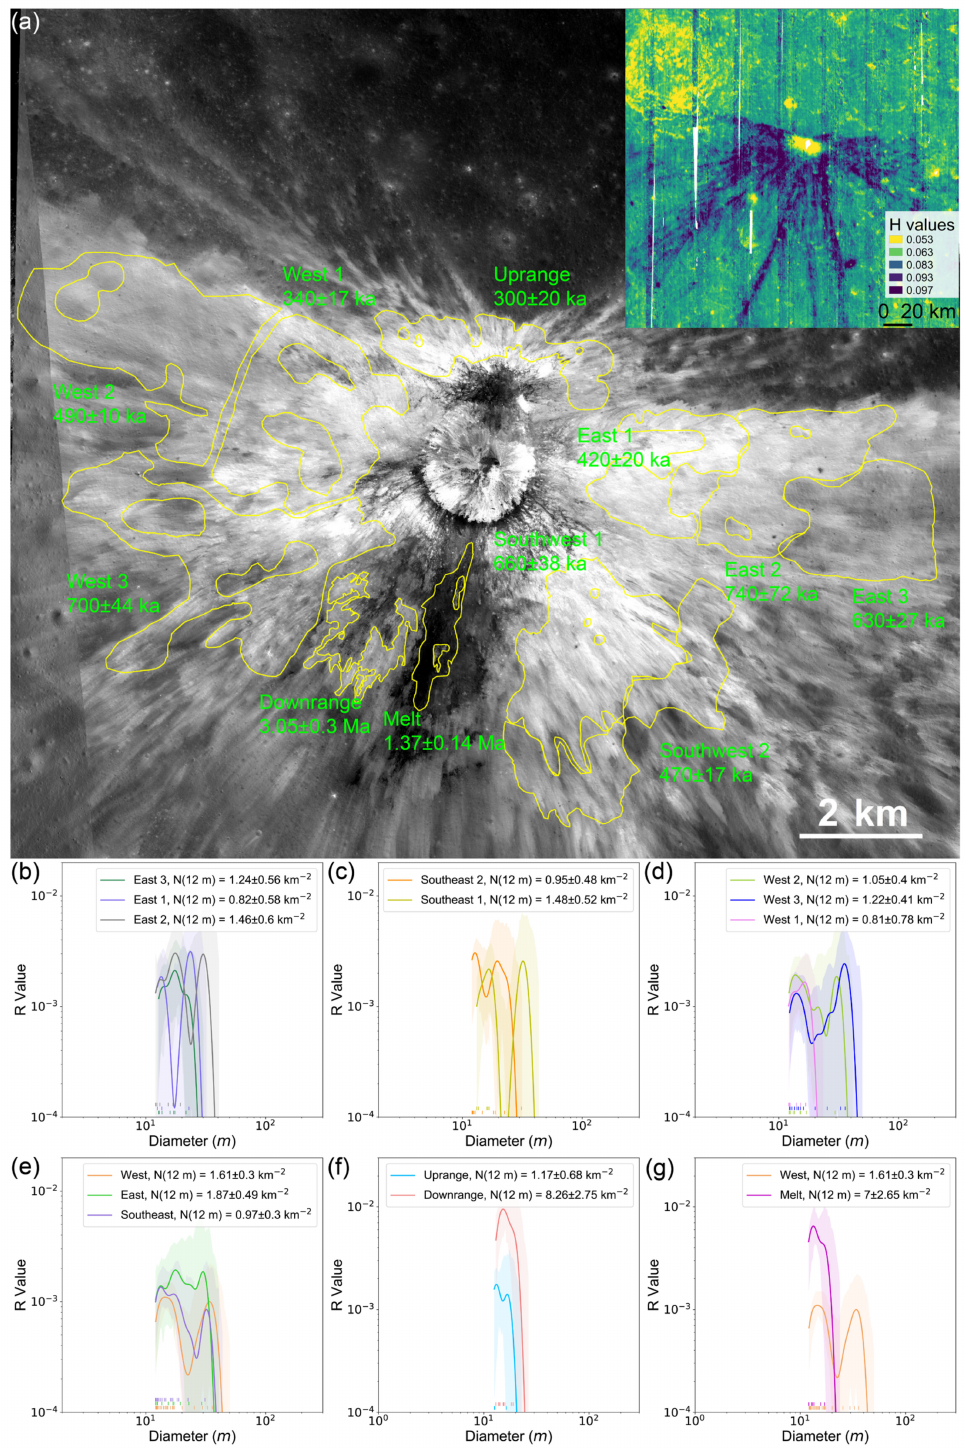
Figure 6. Crater size-frequency distribution on layers of ejecta flows around a cold spot crater ( D = 2112 m) that is centered at 121.31 ◦ E, 18.68 ◦ N. ( a ) This crater was formed by an oblique impactor, which is evidenced by the highly asymmetric rim and distributions of visible ejecta and cold rays. North is up. The inset figure shows the H-map of the cold rays. The eleven counting areas are outlined as yellow polygons. IDs of data used in this figure are compiled in the Supplementary Materials. ( b – g ) compare the crater SFDs on the three counting areas on the western ejecta, two counting areas on the southeastern ejecta, three counting areas on the western ejecta, three combined counting areas (East, West, and Southwest), counting areas at the downrange and uprange, counting areas at the melt flows and western ejecta,